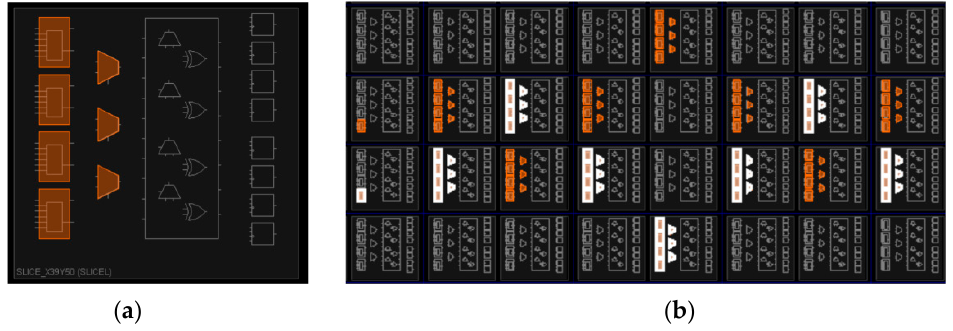
Figure 9. ( a ) Elements in a single slice; ( b ) Two adjacent ROs.